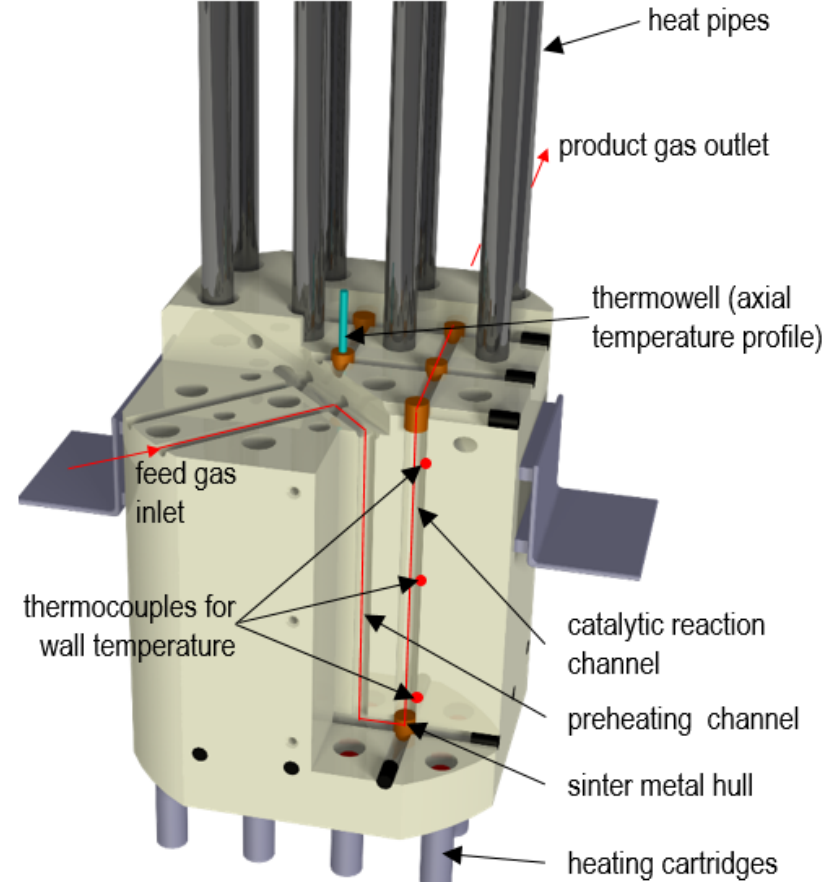
Figure 2. Cutaway scheme of the FAU structured reactor and exemplary gas pathway (reprint from [53] with permission from Elsevier).